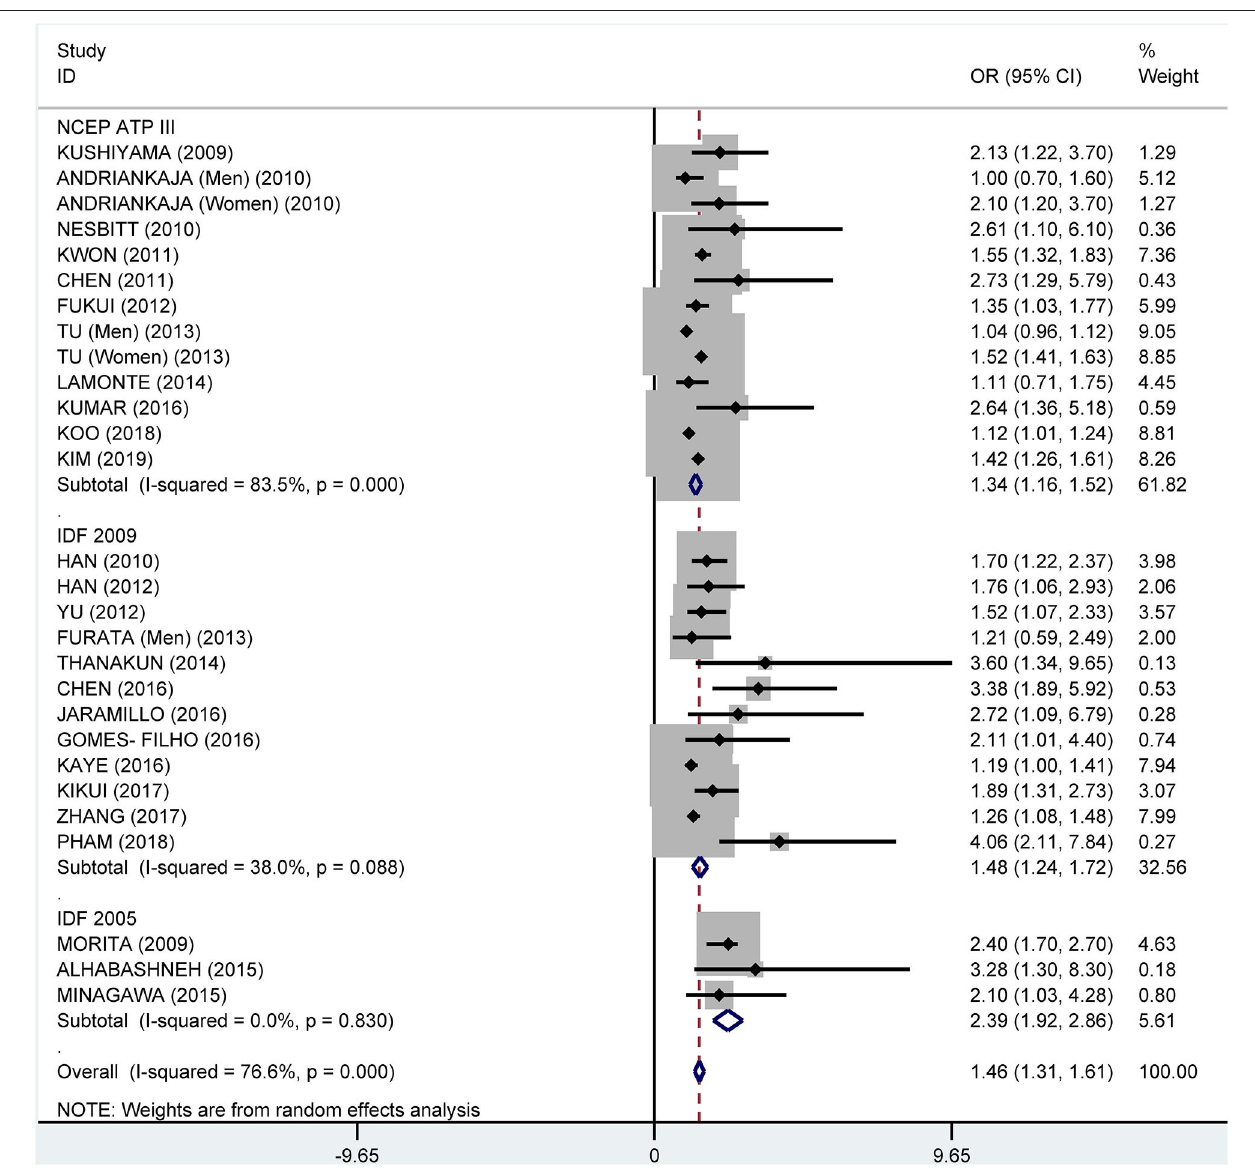
FIGURE 8 | Subgroup analysis of pooled adjusted odds ratios of the association between periodontitis and metabolic syndrome by diagnostic criteria for metabolic syndrome.